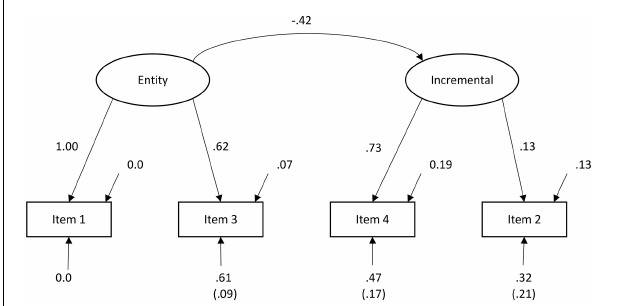
FIGURE 1 | Factor loading diagrams for confirmatory factor analysis (CFA) model fit to a 2-factor model of implicit theories of interest utilizing 4